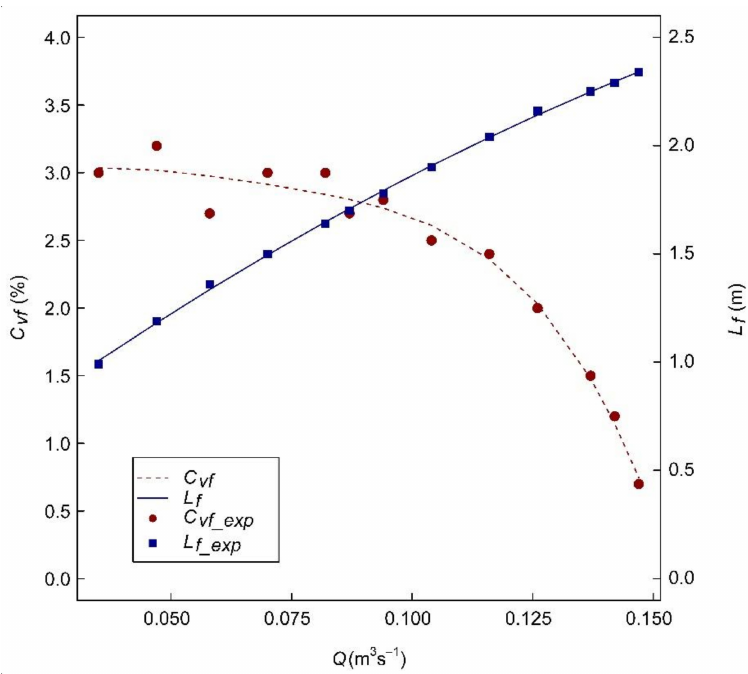
Figure 7. Evolution of the C Vf and Lf for different discharges tested in phase